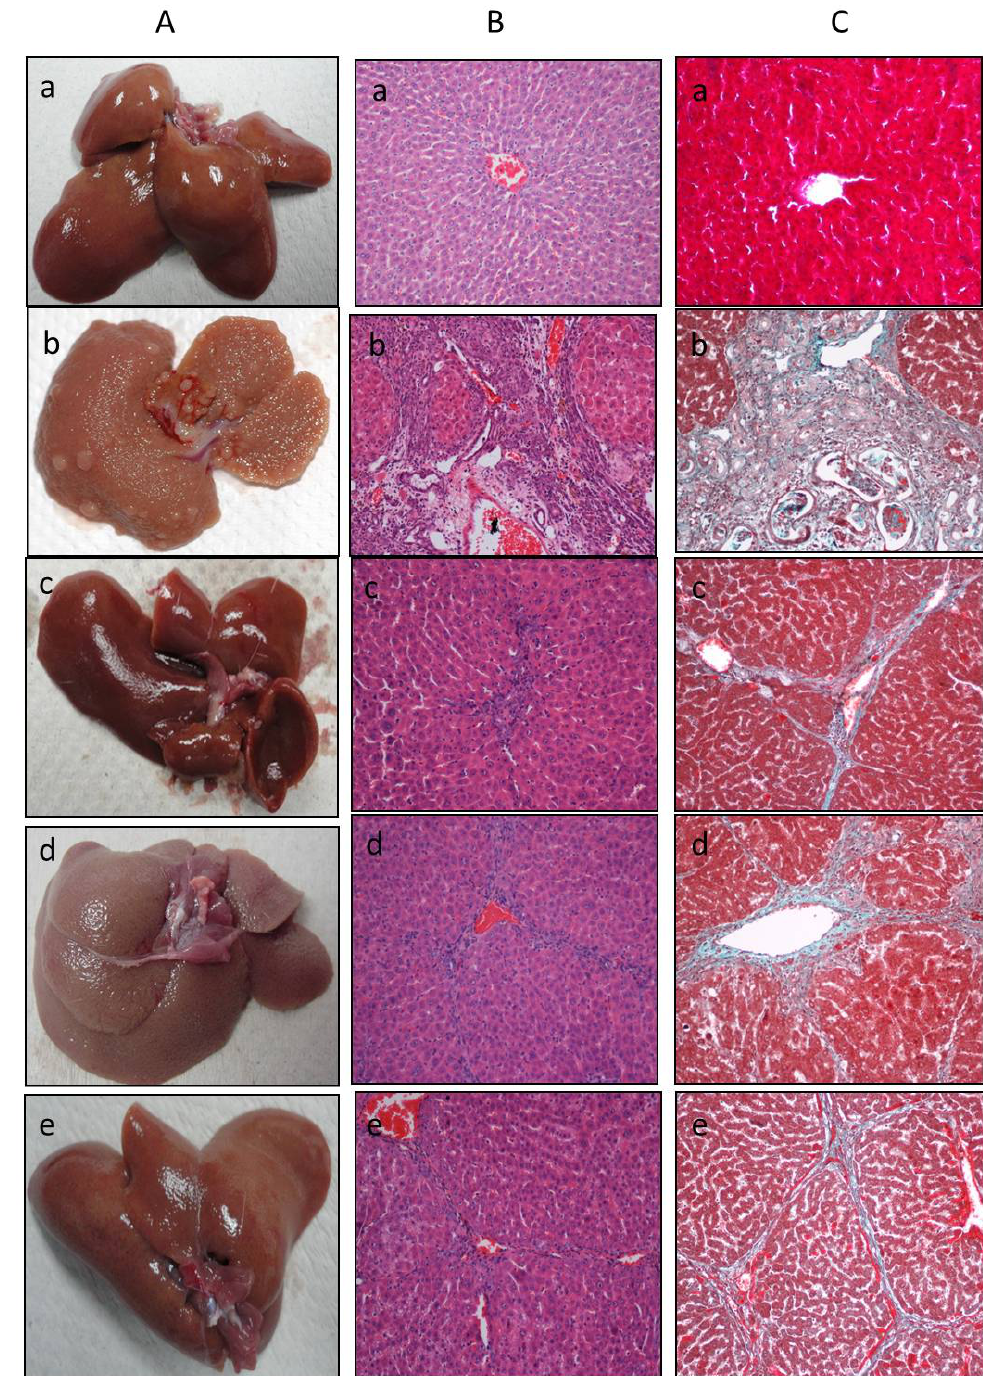
Figure 1. Effects of I. aquatica extract on thioacetamide induced liver damage in rats. (a) Control group, (b) animals treated with thioacetamide, (c) animals treated with thioacetamide and silymarin, (d) animals treated with thioacetamide and I. aquatica 250 mg/kg and (e) animals treated with thioacetamide and I. aquatica 500 mg/kg. ( A ) Gross morphology, ( B ) Hematoxylin/eosin stain, ( C ) Masson trichrome stain; magnification